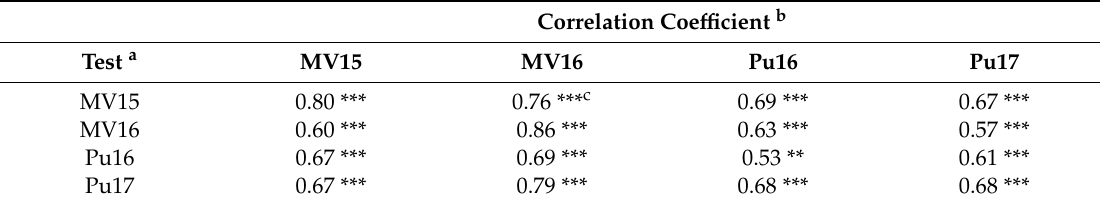
Table 3. Correlation coe ffi cients of infection type (IT) and relative area under the disease progress curve (rAUDPC) of the recombinant inbred lines of AvS × PI 181410 among the field tests in adult-plant stage in the fields under natural infections of Puccinia striiformis f. sp. tritici . Correlation Coe ffi cient